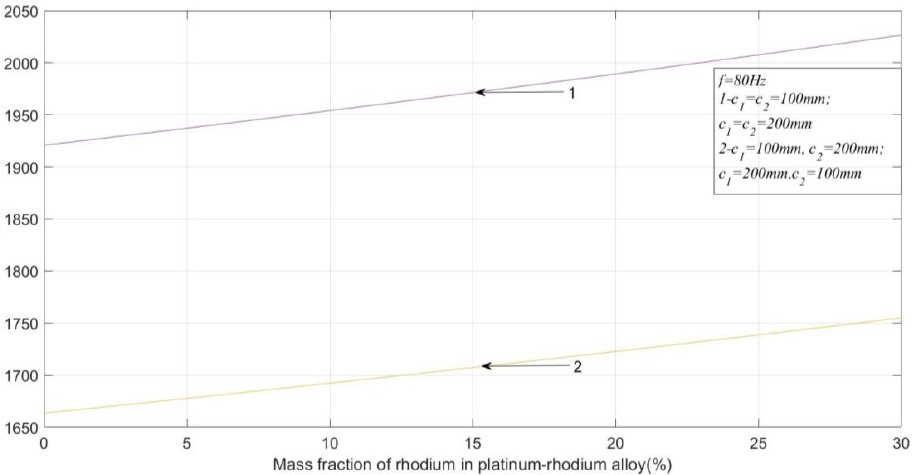
Figure 5. Temperature at the center of the circular opening of the Pt–Rh GFLP.